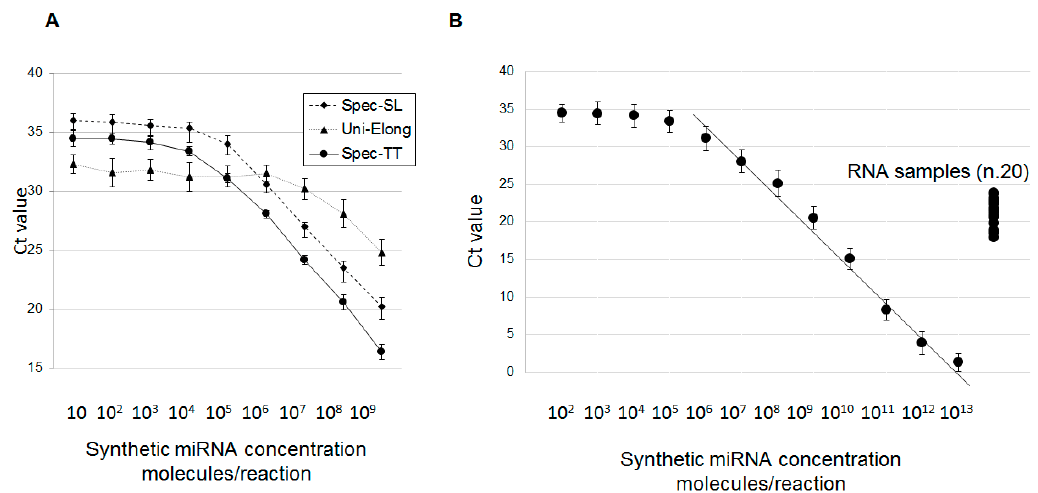
Figure 2. Validation of RT-qPCR system for miRNA analysis. ( A ) Efficacy of Spec-SL, Uni-Elong and Spec-TT systems for RT-qPCR analysis of miR-451 tested with different concentrations of synthetic mimic. All reactions were performed in triplicate. ( B ) Spec-TT systems for RT-qPCR analysis of miR-451 was tested in a broad range of synthetic mimic concentrations (12 2 –10 13 molecules per reaction) and with 20 samples of RNA isolated from randomly selected thyroid node specimens (1 μm per reaction).